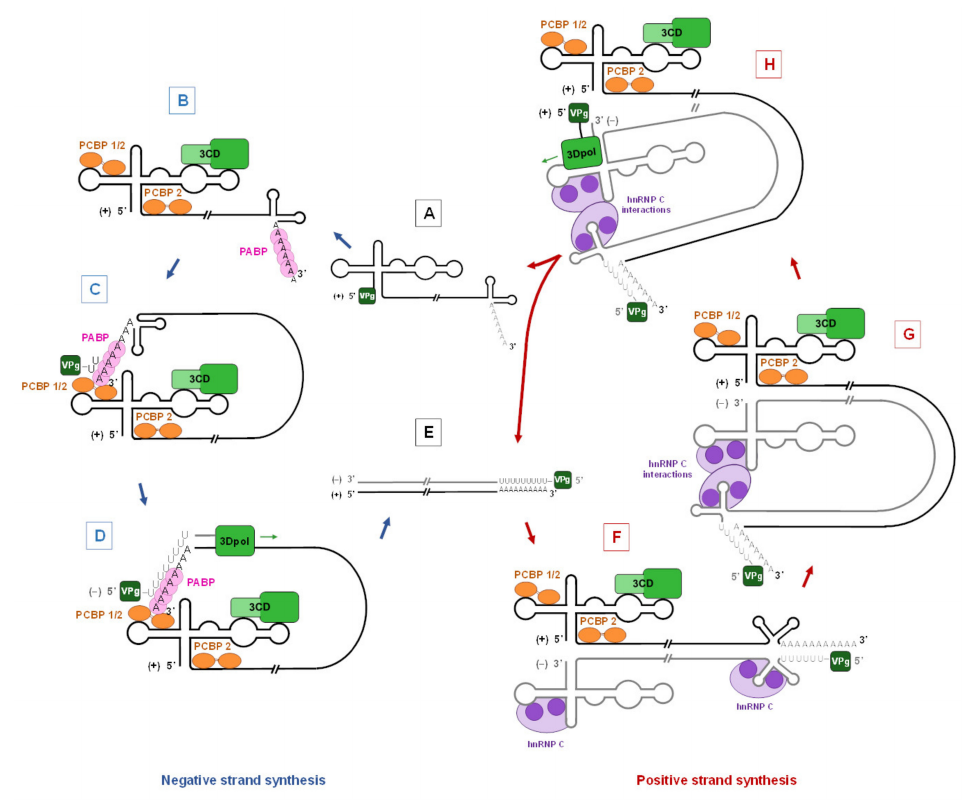
Figure 3. Viral ribonucleoprotein complexes involved in group-B enterovirus genomic